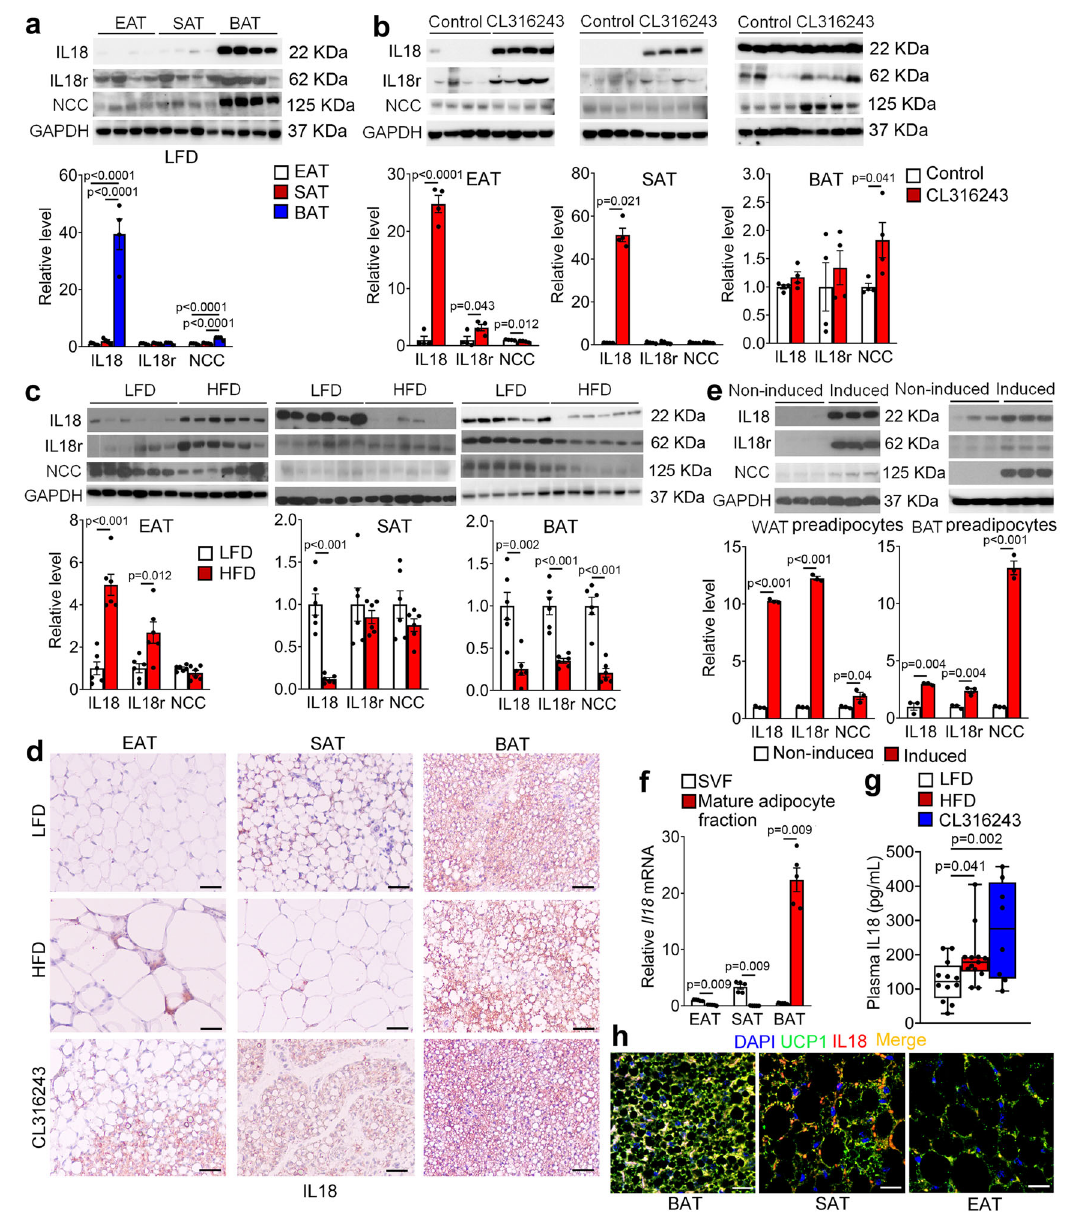
Fig. 1 | Adipose tissue expression of IL18, IL18r, and NCC in response to ther- mogenic activation and high-fat diet (HFD. a – c . Immunoblot analysis and quanti fi cationofIL18,IL18r,andNCCrelativetoGAPDHinEAT,SAT,andBATfrom WT mice on a low fat diet (LFD) ( n =4 per group) ( a ), after thermogenic activation with 1mg/day/kg CL316243 i.p. injection for 7 days ( n =4 per group) ( b ), or fed a HFD for 12 weeks ( n =6 per group) ( c ). d IL18 immunostaining of representative epididymal adipose tissue (EAT), subcutaneous adipose tissue (SAT) and brown adiposetissue(BAT)sectionsfrommicefedaLFD,aHFD,ortreatedwithCL316243 (n =8 per group); scale bar: 50 μ m. e Immunoblot analysis and quanti fi cation of IL18,IL18r,andNCCrelativetoGAPDHindifferentiatedwhiteorbrownadipocytes